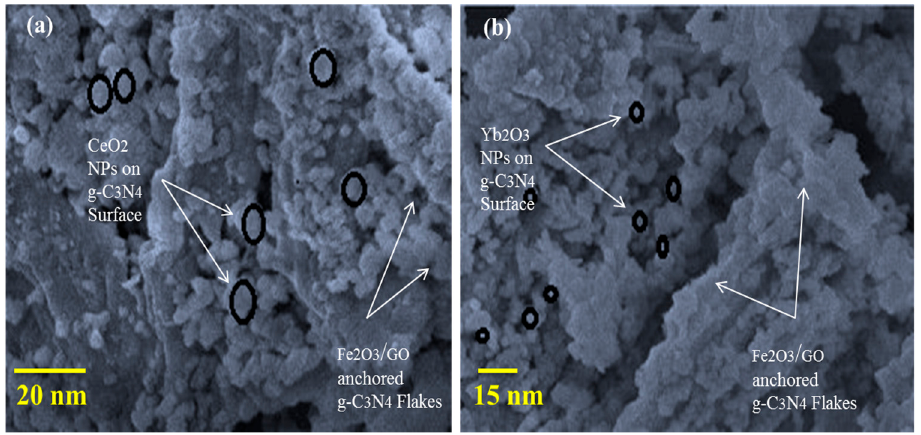
Figure 3. SEM images of ( a ) Ce/GOCN IONPs; ( b ) Yb/GOCN